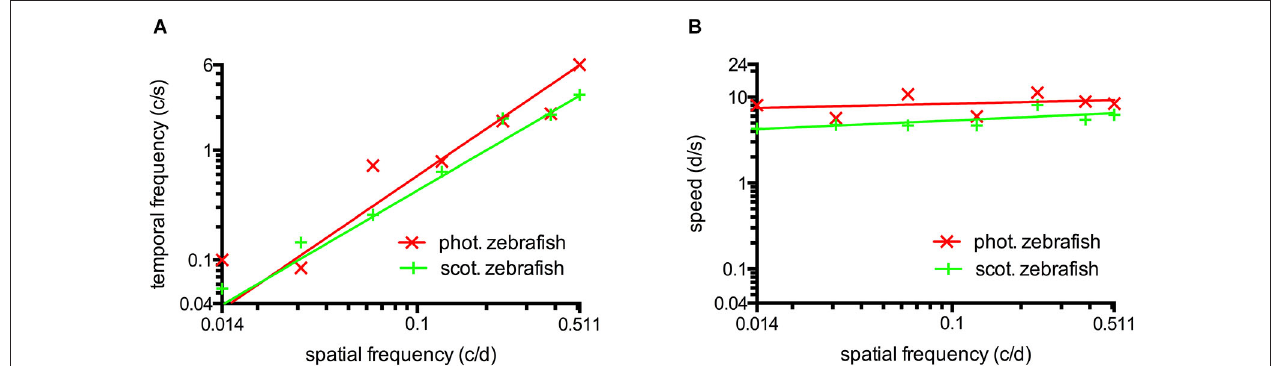
maximal CS as a function of spatial frequency. Maximum CS was triggered by a similar speed for a broad range of different spatial frequencies indicating tuning for speed at photopic and scotopic luminance levels. Straight lines were calculated by logarithmic nonlinear